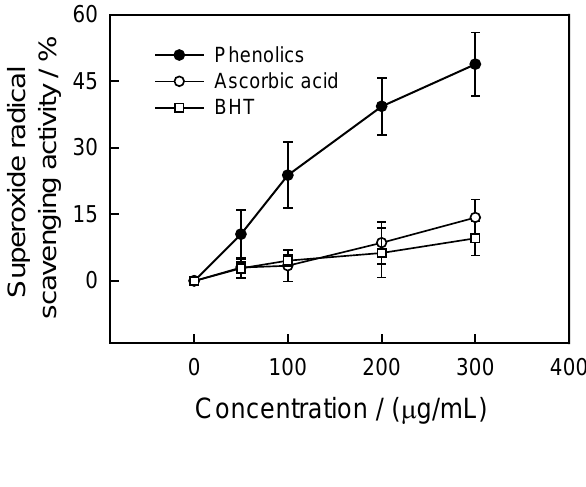
Figure 6. Superoxide radical scavenging activity of phenolics from CWC tissues.